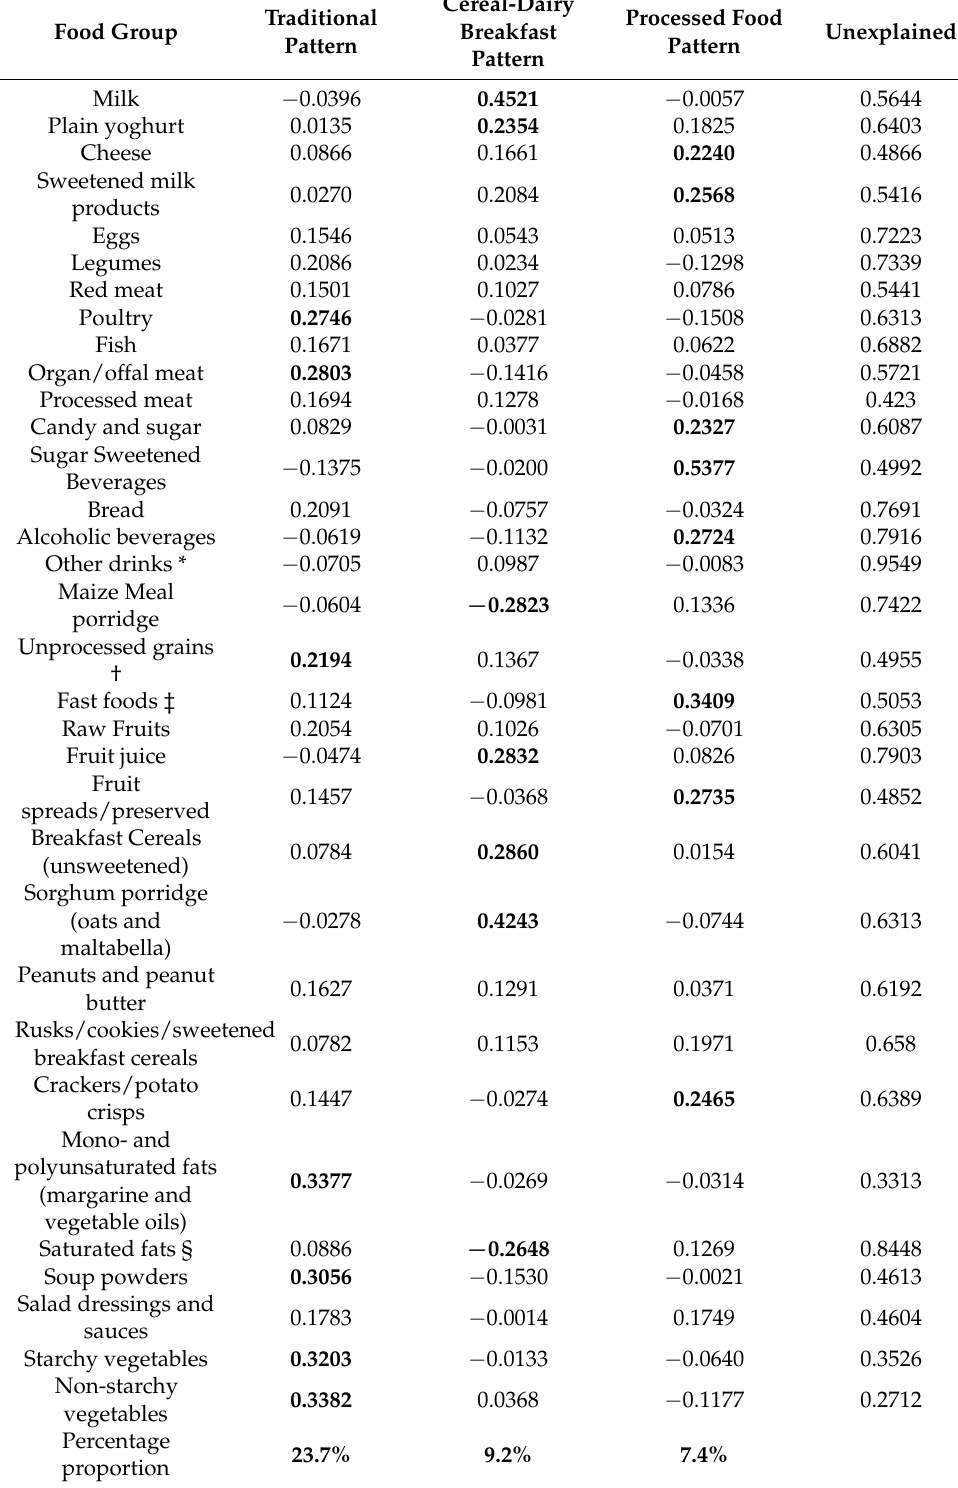
Table 2. Factor loadings for significant food groups (>0.21) derived from principle component analysis with a covariance matrix and orthogonal rotation